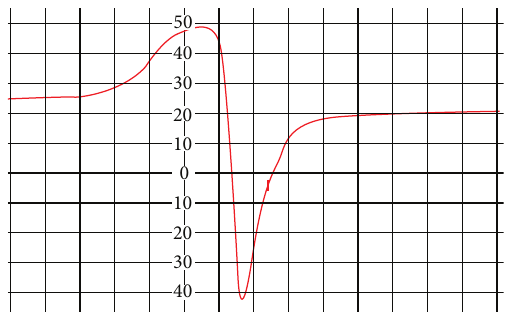
Figure 3: ESR spectrum of Cu(II)